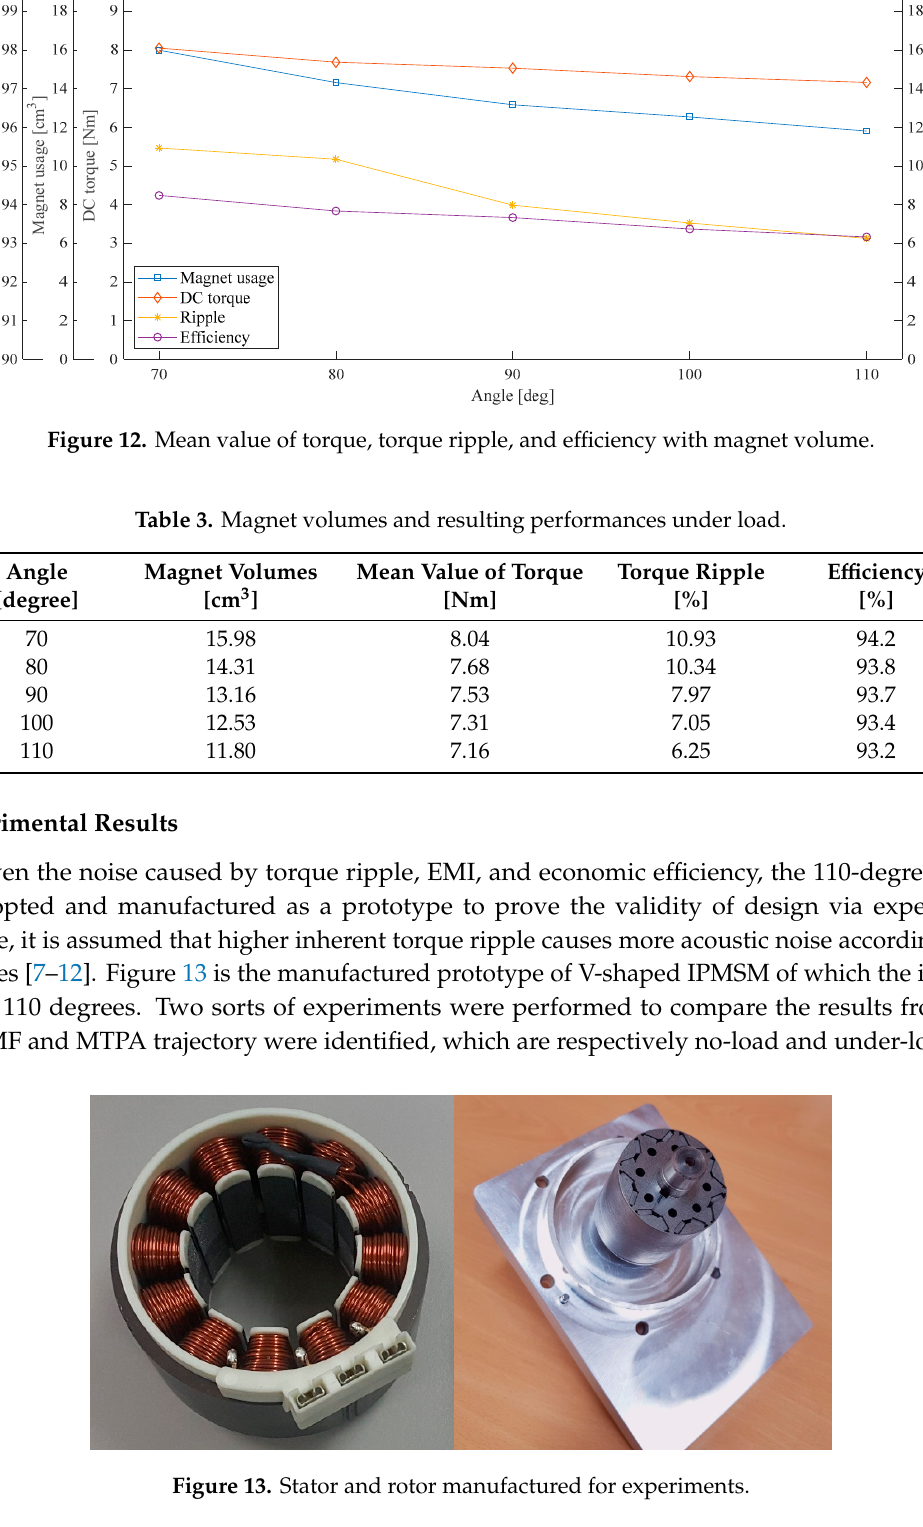
Figure 14. The experimental testbed for no-load and under-load tests. 5.1. Back-EMF Dynamometer in Figure 14 provides constant speed control for no-load test of the fabricated motor. Figure 15 are waveforms of phase voltage of U (blue line) and V (purple line) and line to line voltage U to V-phase (green line). Each result was obtained at 6000 r/min and 8000 r/min from power analyzer connected to the terminals of the manufactured motor. Peak values were measured to be 179 V peak for phase voltage and 282 V peak for line to line voltage at 400 Hz (3000 r/min) while at 534 Hz (8000 r/min) 232 V peak , 239 V peak for U and V-phase and 372 V peak for line to line are measured. These results are deviated from the results shown in Section 4.2. The reason for this deviation was a gap between the rotor core and interior PM in magnet cavity.